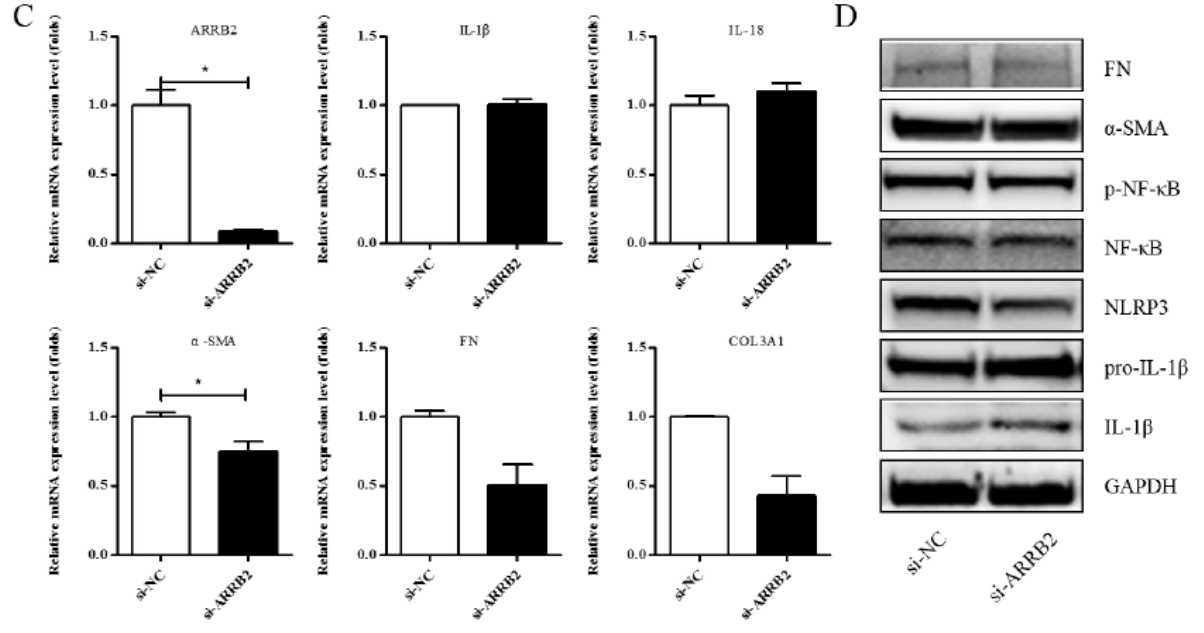
Figure 4. Effects of si-NLRP3 on inflammation and liver fibrosis in LX-2 cells. LX-2 cells were transfected transiently with siRNA-NLRP3 for 48 h. ( A ) Real-time PCR analysis showed that the levels of NLRP3, IL-1 β , IL-18, α -SMA, COL1A1 and COL3A1 mRNA were significantly downregulated by NLRP3 silencing. ( B ) The protein expression levels of α -SMA, FN, p-NF- κ B, and IL-1 β decreased dramatically after LX-2 cells were induced to down-express NLRP3. ( C , D ) Expression of the above genes at the mRNA and protein levels in LX-2 cells, when LX-2 cells were transfected transiently with siRNA-ARRB2 for 48 h (n = 3). Student’s t -test was used for statistical analysis. The results shown are mean ± standard error. * p < 0.05, ** p < 0.01.